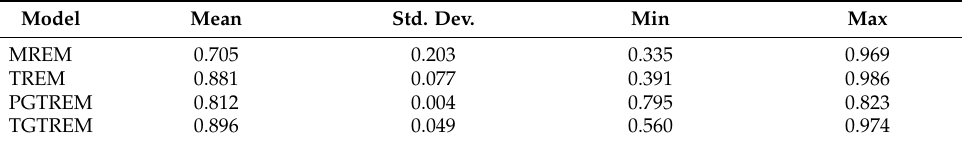
Table 6. Descriptive statistics of the estimated energy efficiency scores.